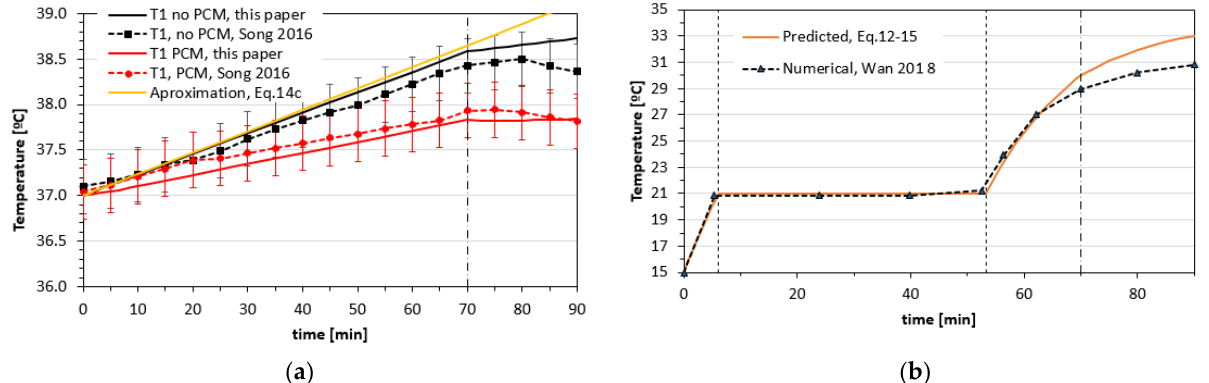
Figure 5. Predicted temperature profiles compared with literature data: ( a ) Measured body core tem- perature T 1 (dashed lines, Song [6]) and analytical results (full lines) for the case without PCM cooling (black lines) and with PCM (red lines); ( b ) PCM temperature T 3 as predicted by Equations (12)–(15) (full line) compared with numerical data from Wan [23] (dashed line with